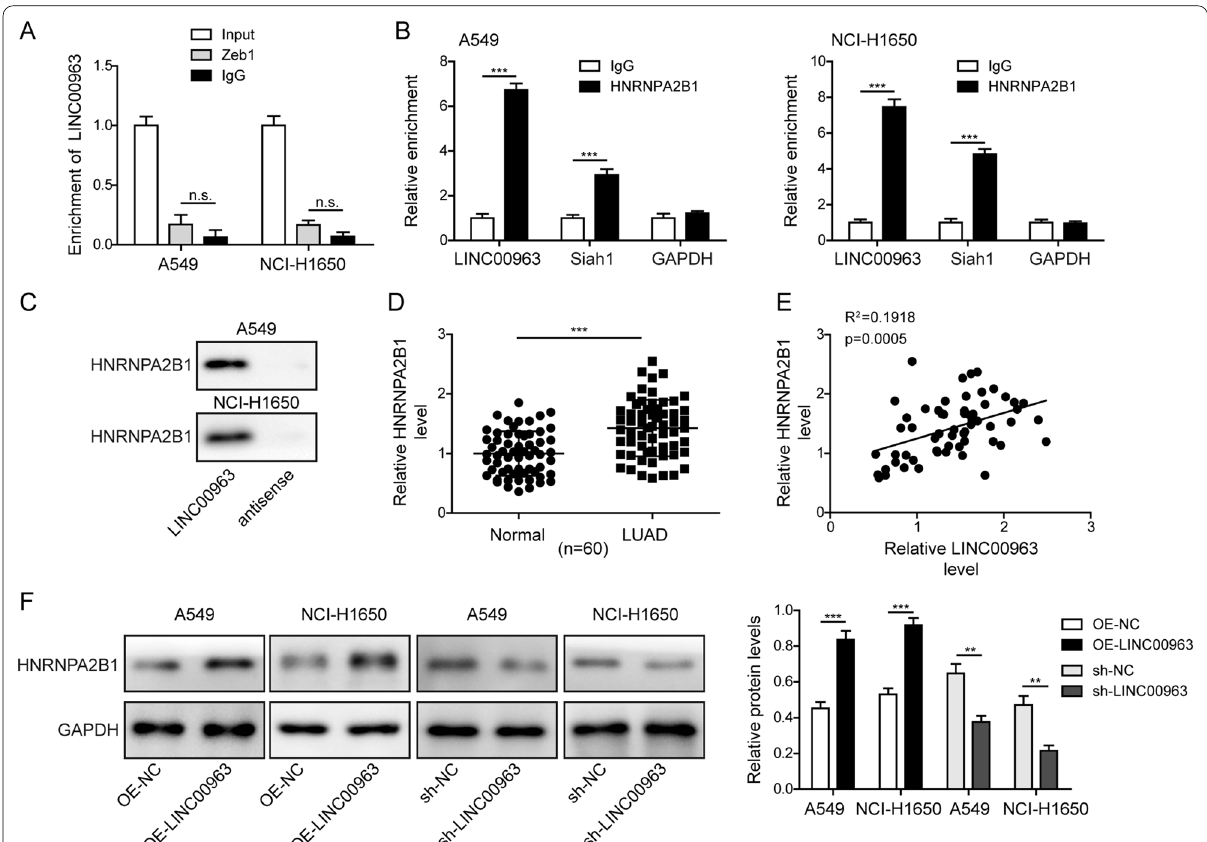
Fig. 7 LINC00963 physically interacted with HNRNPA2B1 protein. A The potential interaction between LINC00963 and Zeb1 protein was assessed by RIP assay using anti-Zeb1 or IgG (negative control) antibody. B The potential interaction between HNRNPA2B1, LINC00963, and Siah1 mRNA was examined by RIP assay using anti-HNRNPA2B1 and IgG (negative control) antibody. C RNA pull-down assay verified the interaction between LINC00963 and HNRNPA2B1 protein. D RT-qPCR measured HNRNPA2B1 expression between 60 pairs of LUAD tissues and matching noncancerous lung tissues. E The association between LINC00963 and HNRNPA2B1 levels in 60 LUAD tissues was analyzed by Pearson correlation analysis. F HNRNPA2B1 expression in indicated cells was examined by western blot. n.s. , not significant, * P < 0.05, ** P < 0.01 and *** P <